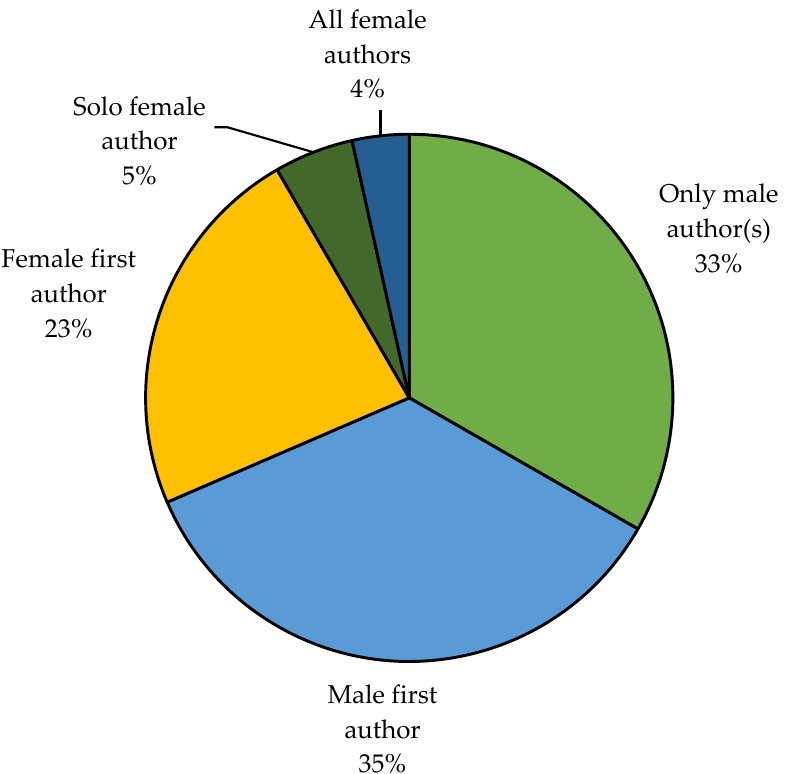
Figure 4. The proportion of Gold Access publications by gender-based authorship structures.